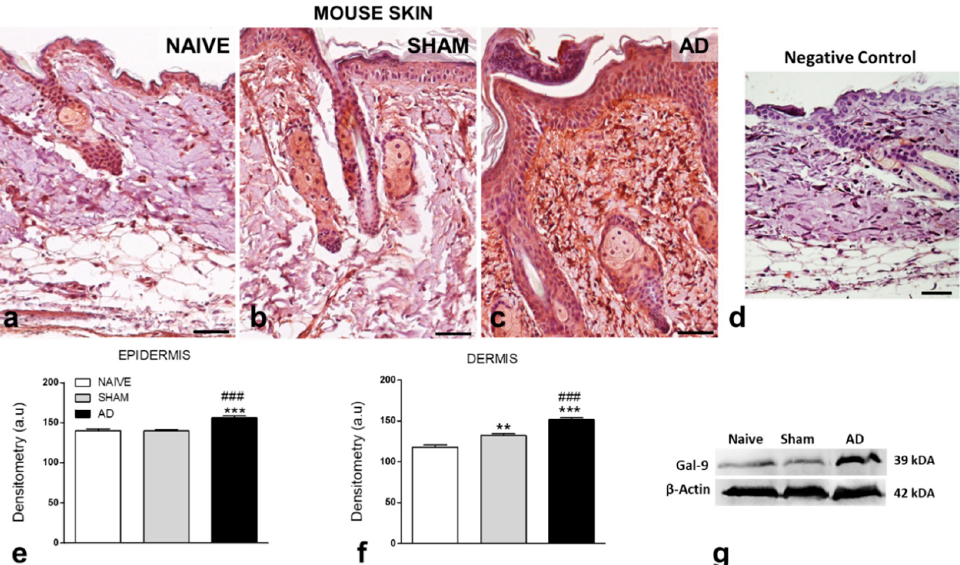
Figure 3. Expression of Gal-9 in the mouse skin. ( a - c ) Intense immunoreactivity for Gal-9 in the mouse epidermis and dermis detected in the AD group compared to controls (Naïve and Sham groups). ( d ) Negative control shows absence of immunoreactivity for Gal-9. Counterstain: hematoxylin. Scale bars: 40 µm. ( e , f ) Densitometric analysis of Gal-9 expression in mouse epidermis and dermis. Data represent means ± SEM of Gal-9 expression in arbitrary units (a.u.) ( n = 5 ani- mals/group). ** p < 0.01, *** p < 0.001 vs. Naive; ### p < 0.001 vs. Sham (Kruskal–Wallis, Dunn post-test). ( g ) Western blot analysis to measure Gal-9 levels in the mouse skins. β -actin was used as a protein loading control (data represent one ### p < 0.001 vs. Sham (Kruskal–Wallis, illustrative blot from two independent experiments). imals/group). ** p < 0.01, *** p < 0.001 vs. Naive;